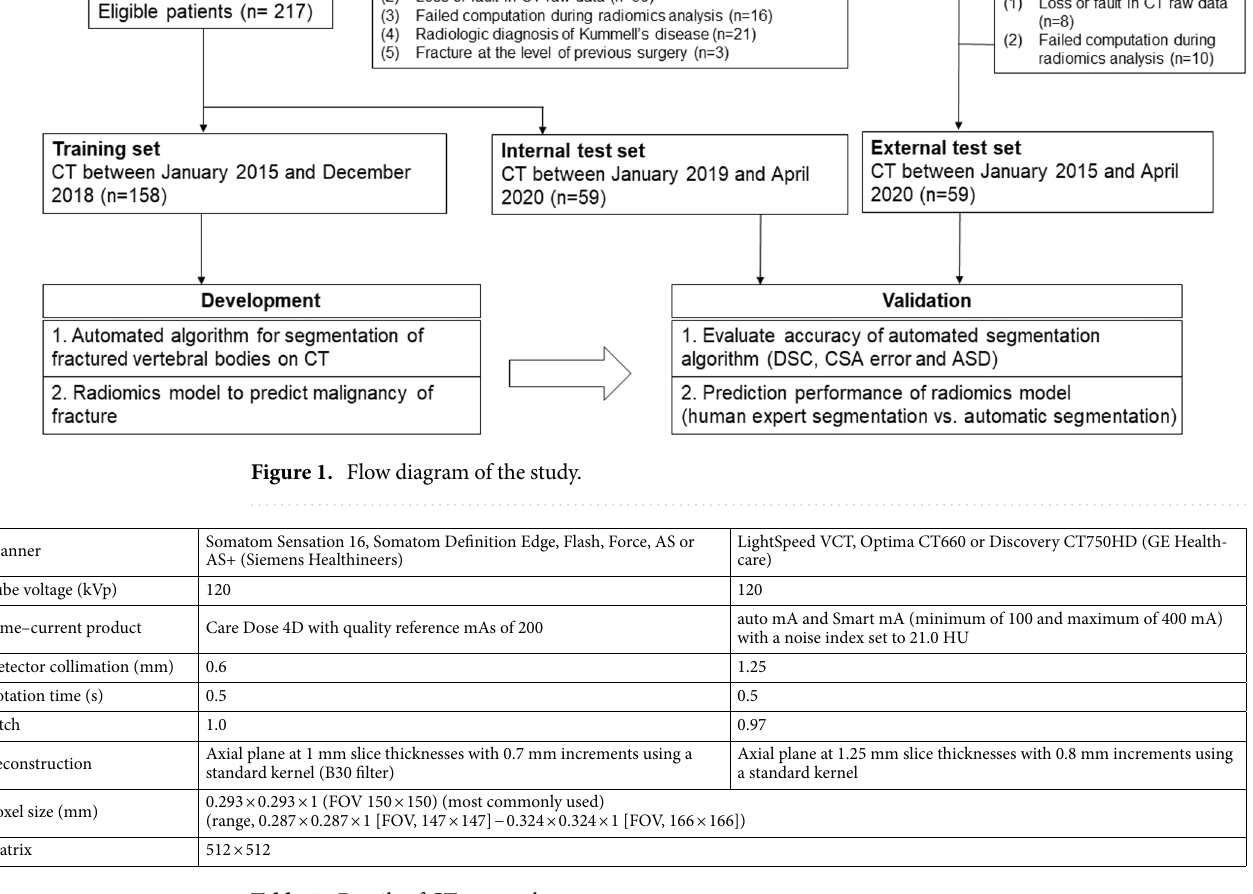
Table 1. Details of CT